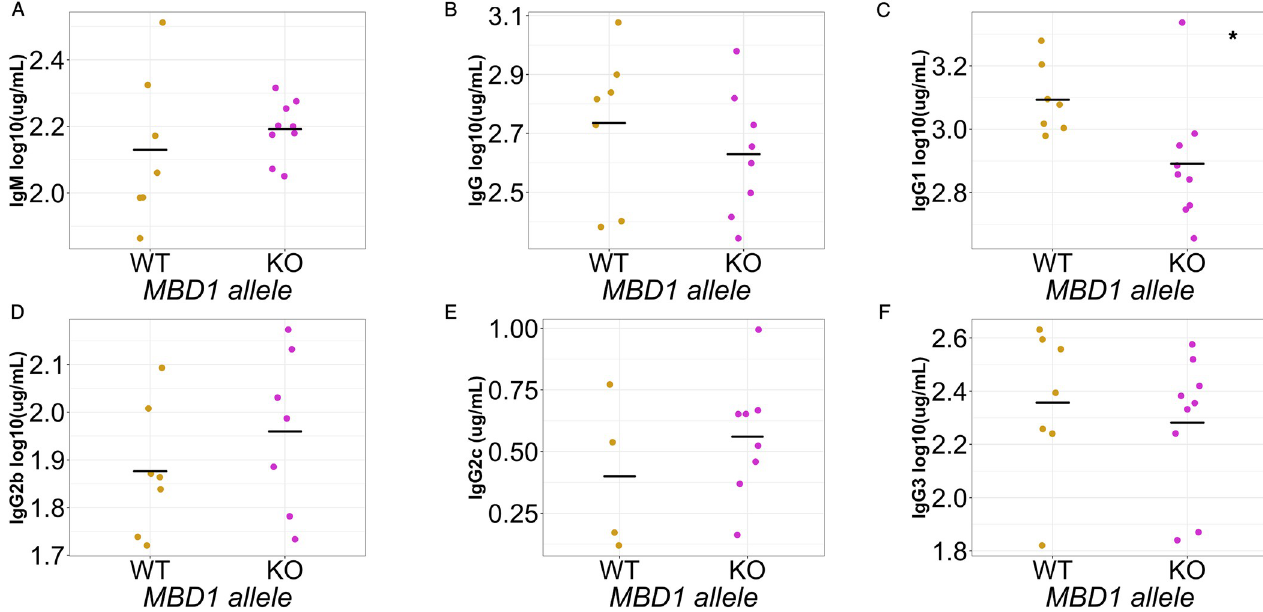
Fig 6. MBD1 regulates homeostatic serum IgG1 levels. Log10 transformed serum antibody concentrations for (A) IgM, (B) total IgG, (C) IgG1, (D) IgG2b, (E) IgG2c, and (F) IgG3. The data shown represent one of two independent experiments, each performed with 6–9 animals from each genotype. Each point represents an individual animal measurement, and the grey crossbar indicates the mean for each genotype. ( � p < 0.05) p-values determined using Student’s t test.